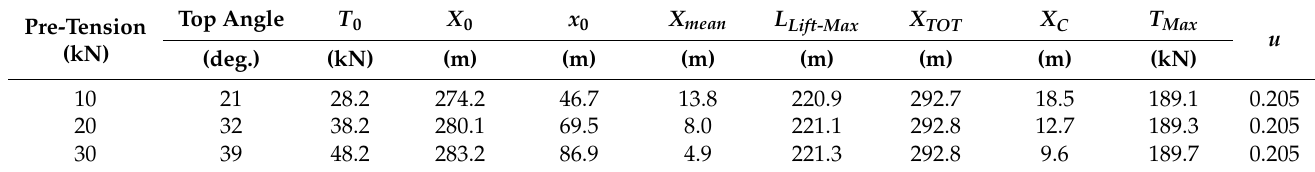
Table 14. Case 1, Increased Diameter = 44 mm, quasi-static results.